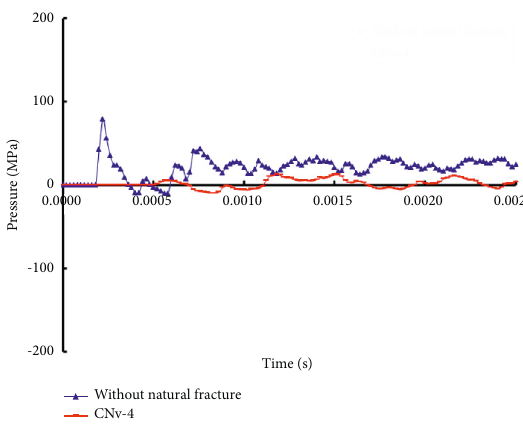
Figure 18: P-T curve for Case CN